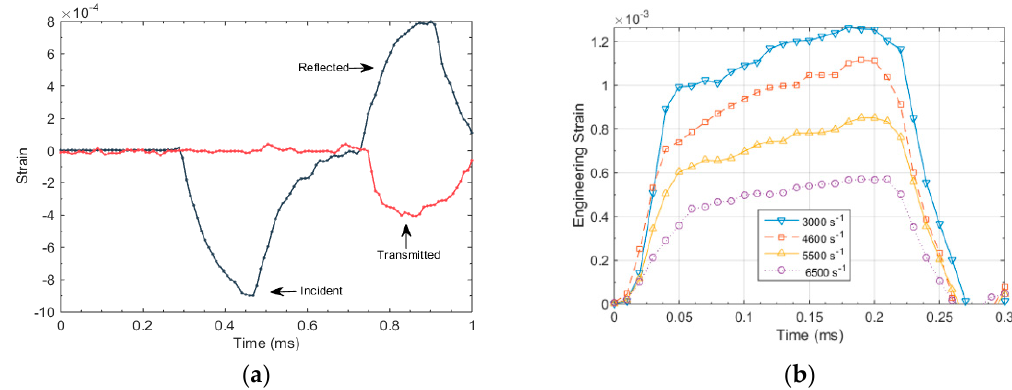
Figure 11. ( a ) Typical incident, reflected and transmitted pulses in a Kolsky bar experiment; ( b ) Incident pulses at different strain rates.